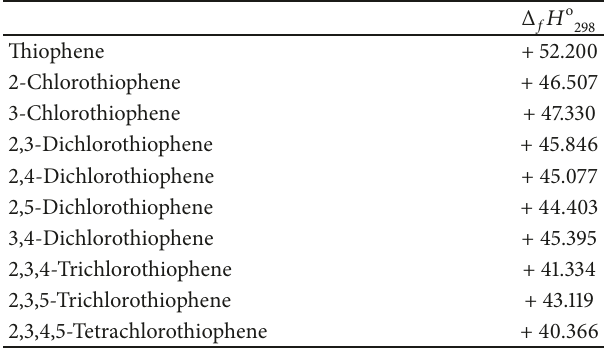
Table 2: (cid:2) 𝑓 𝐻 o 298 (kcal/mol) for chlorinated thiophene isomers.